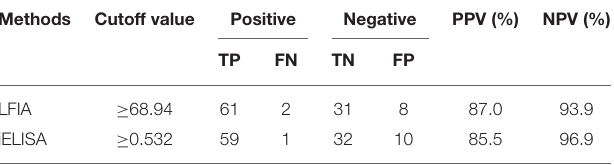
FIGURE 4 | The specificity picture from left to right was (A) positive brucellosis serum, (B) Staphylococcus epidermidis serum, (C) Streptococcus anginosus serum, (D) Escherichia coli O157:H7 serum, (E) Klebsiella pneumoniae serum, (F) Staphylococcus aureus serum, (G) Staphylococcus saprophyticus serum, (H) Ralstonia picri serum, (I) Salmonella enteritidis serum, and (J) Streptococcus salivarius serum. TABLE 1 | The evaluation results of our developed LFIA and iELISA.